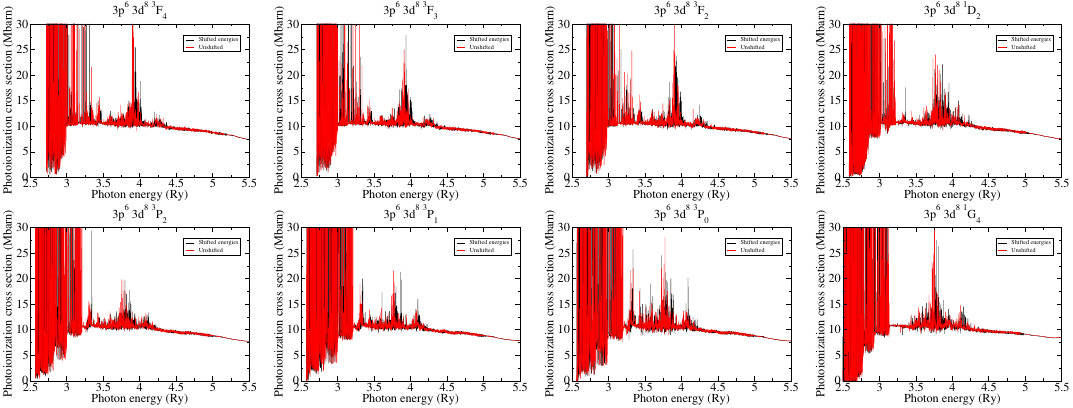
Figure 2. Photoionization of Ni 2 + from several initial states. Black line: target energies shifted to NIST recommended values. Red line: target energies unmodified from the GRASP